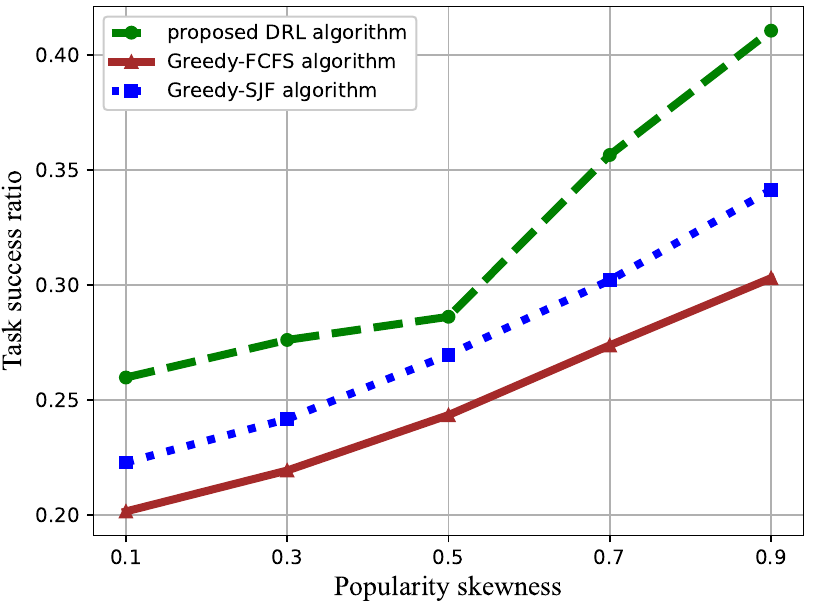
Figure 11. Success ratio versus the popularity skewness. The performance of the proposed algorithm, the average task satisfaction degree, and the success ratio with different VMs are illustrated in Tables 3 and 4, where the number of VMs was set to 2, 3, and 4, respectively. The proposed algorithm achieves better performance than the greedy-FCFS and greedy-SJF methods on the task satisfaction degree and success ratio. This is because the scheduler always selects the VM that minimizes the response time for the current scheduled task without taking the future tasks into